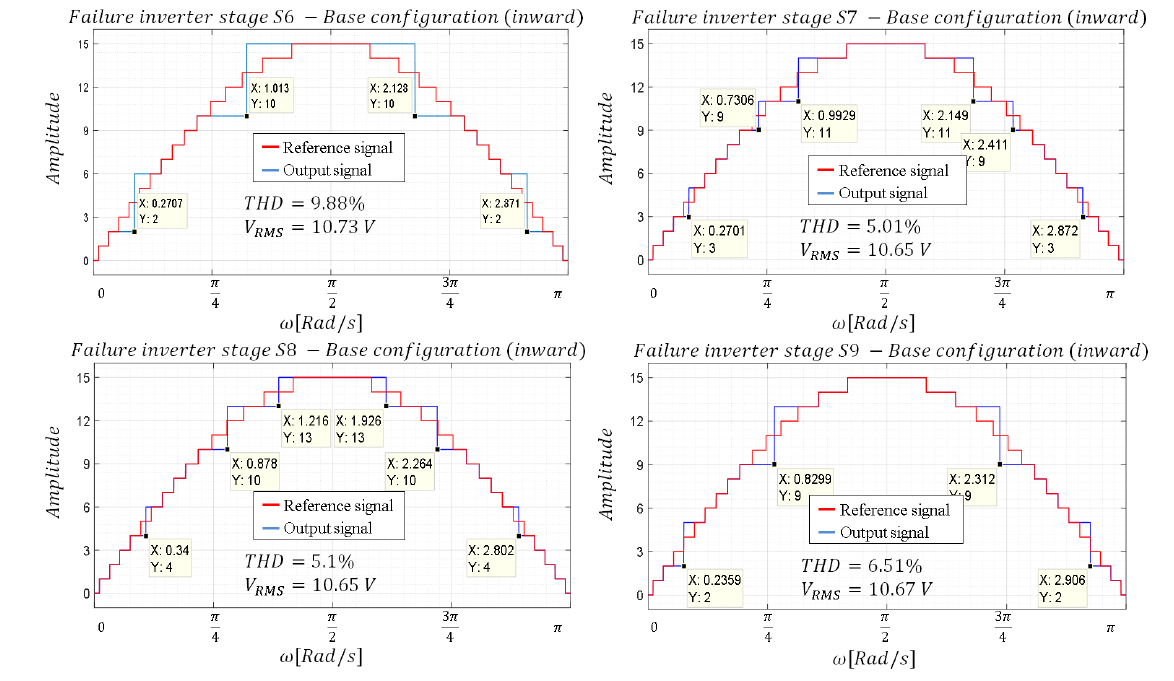
Figure 11. Waveforms—Base configuration with inward alignment.